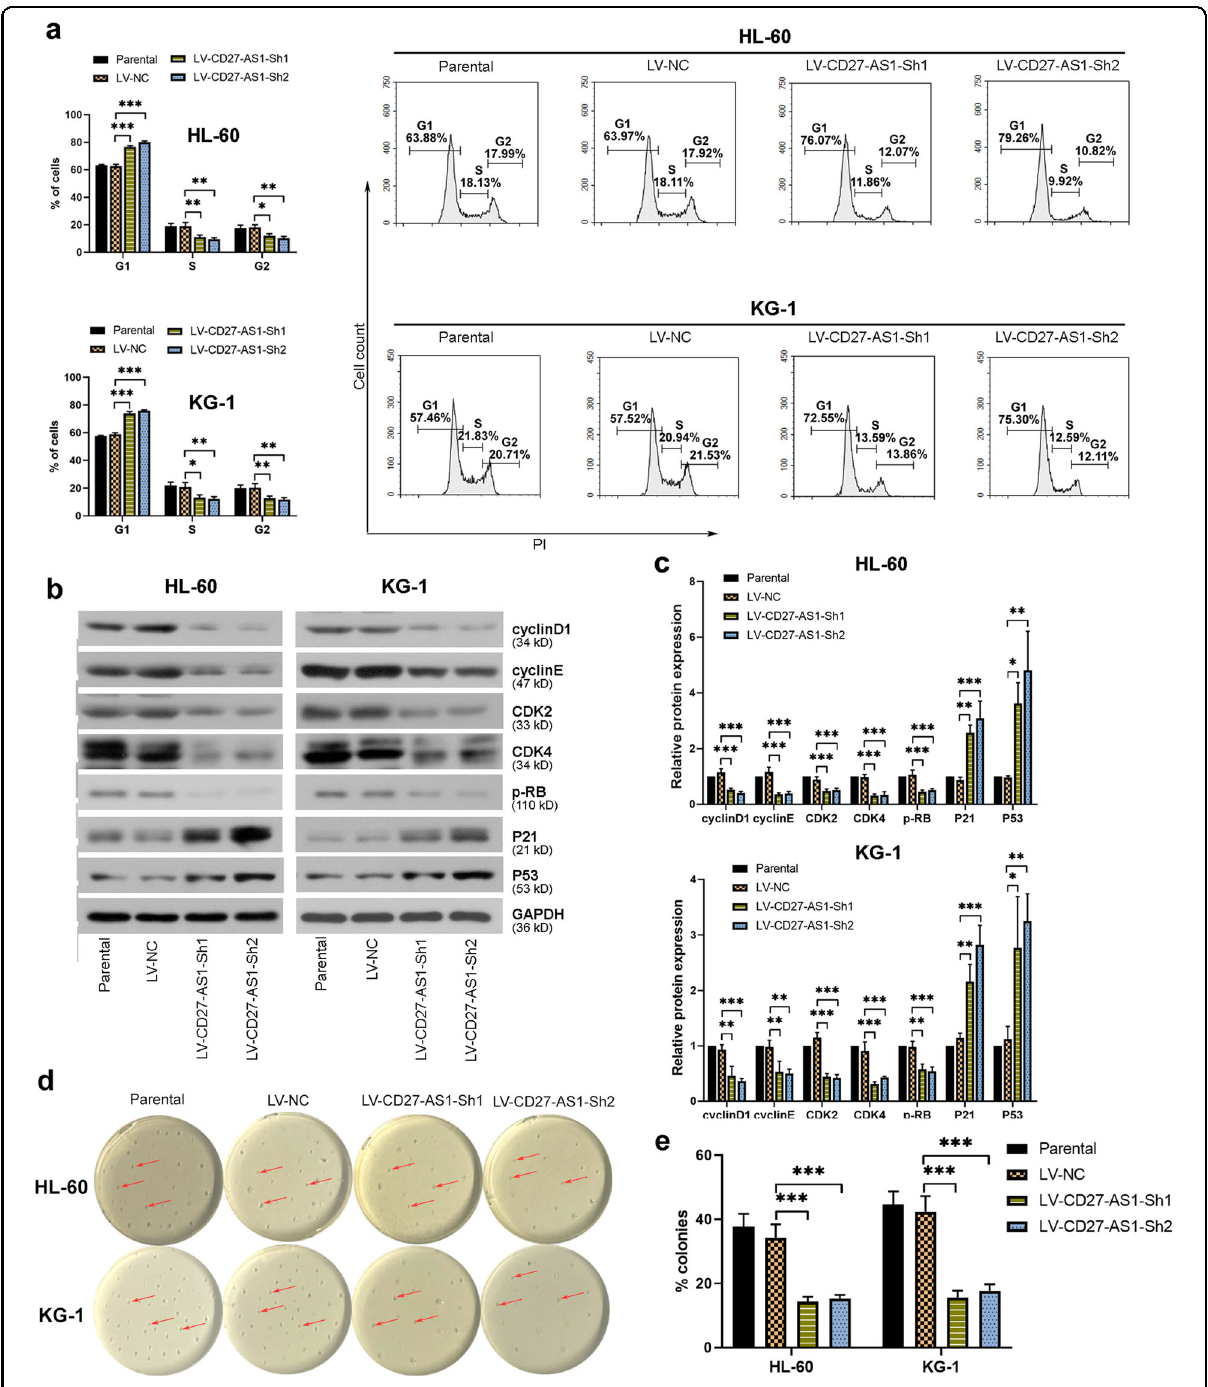
Fig. 3 Knockdown of CD27-AS1 inhibits cell cycle progression and colony formation in the AML cell lines. HL-60 and KG-1 cells were infected with two LV-CD27-AS1-shRNAs. a Flow cytometry was performed to assess cell cycle distribution in infected AML cells. b Western blotting was used to check protein expression levels of cyclinD1, cyclinE, CDK2, CDK4, p-RB, P21, and P53 in the AML cells with CD27-AS1 knockdown. c Quanti fi cation of protein levels from western blotting was analyzed. d , e Colony formation of AML cells was detected by using methylcellulose clonogenic assay. N = 3. Data were shown as means ± SD. * P < 0.05, ** P < 0.01, and *** P < 0.001. AML, acute myeloid